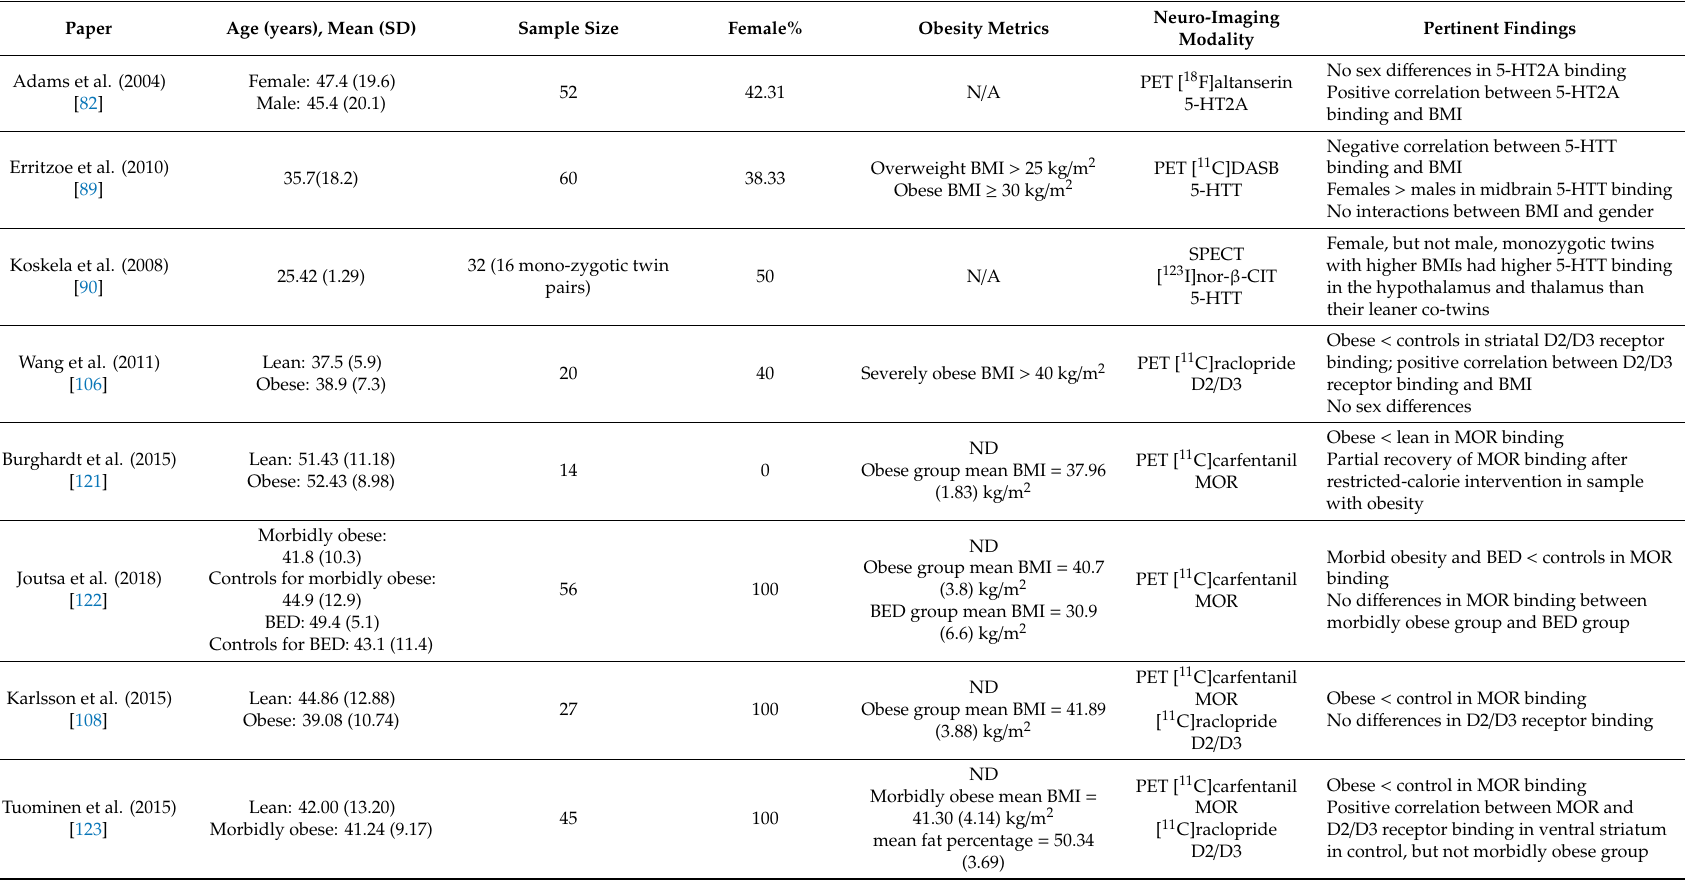
Table 4. Brain neurotransmission study sample characteristics and